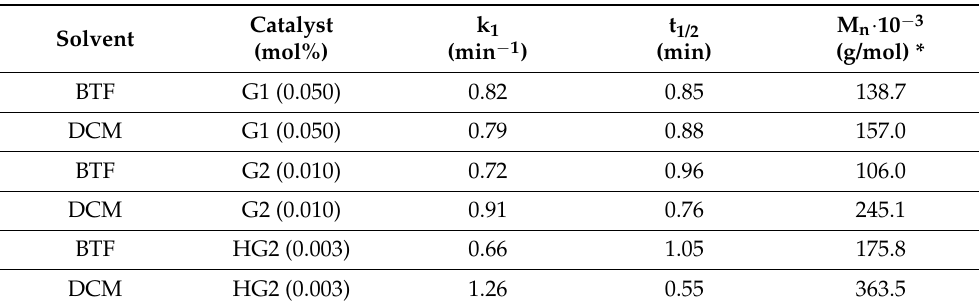
Table 1. The catalyst contents, rate constant (k 1 ), and half-life (t 1/2 ), determined by fitting the data of monomer consumption in the first 3 min, and the average molecular weight (M n ) of the polymers obtained in the ring-opening metathesis polymerization of norbornene in benzotrifluoride (BTF) and dichloromethane (DCM) solvents at 25 ◦ C.